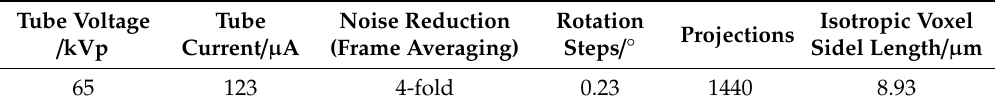
Table 1. Scanning parameters for µ-CT-imaging.